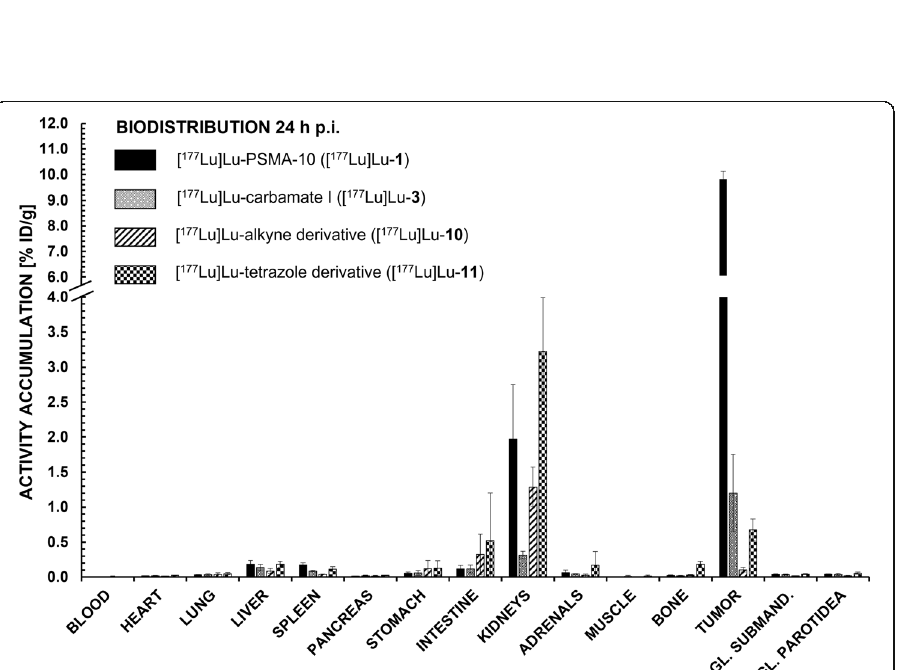
Fig. 4 Biodistribution data (% ID/g) of [ 177 Lu]Lu-PSMA-10 ([ 177 Lu]Lu- 1 ), [ 177 Lu]Lu- 3 , [ 177 Lu]Lu- 10 and [ 177 Lu]Lu- 11 in tumor xenograft-bearing CB17-SCID mice at 24 h p.i. ( n = 4 for [ 177 Lu]Lu- 10 and n = 5 for all other experiments). Submandibular and parotid glands were dissected separately and their values are depicted in the columns ‚ GL. SUBMAND. ‘ and ‚ GL. PAROTIDEA ‘ ,